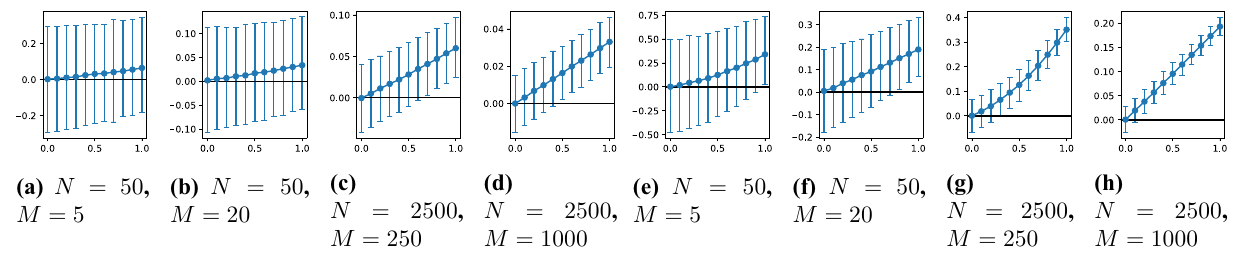
Fig. 9 The near-linear relationship between p (proportion of proposi- tions which value is obtained under a lower estimation noise, x -axes) and the improvement in mean true value of the selected propositions ( y -axes) under the normal assumptions. In each plot, the dot repre- sents the sample mean, and the error bar represents the 5–95% per-